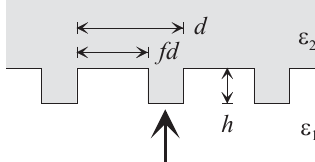
Figure 1. Considered problem.